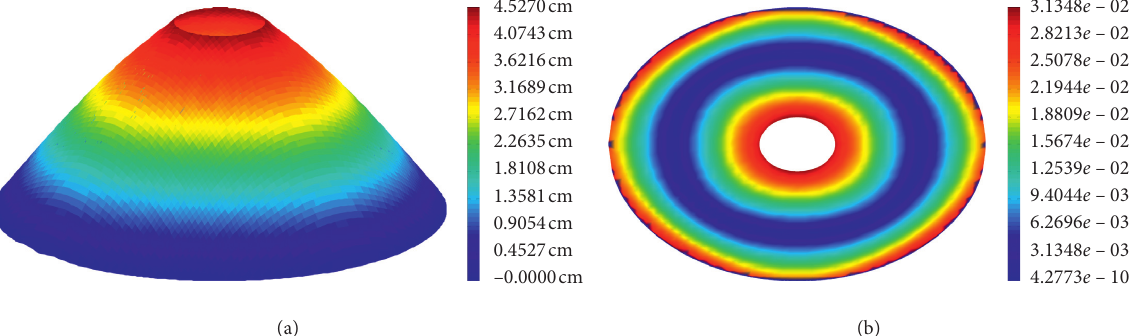
Figure 14: Deflections (a) and deflection errors (b) of a simply supported annular plate under a distributed load calculated with the proposed NMM with 0.2 × 0.2 mesh.